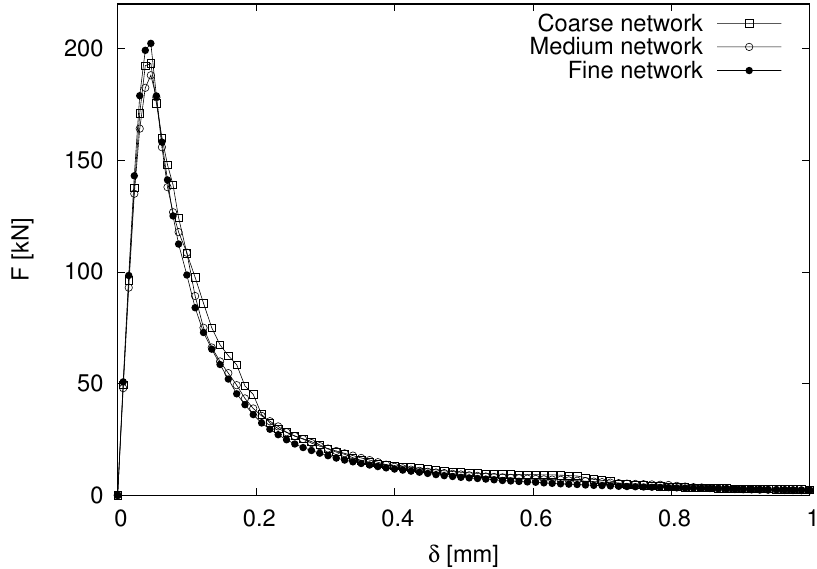
Figure 11. Load versus load-point-displacement results for three